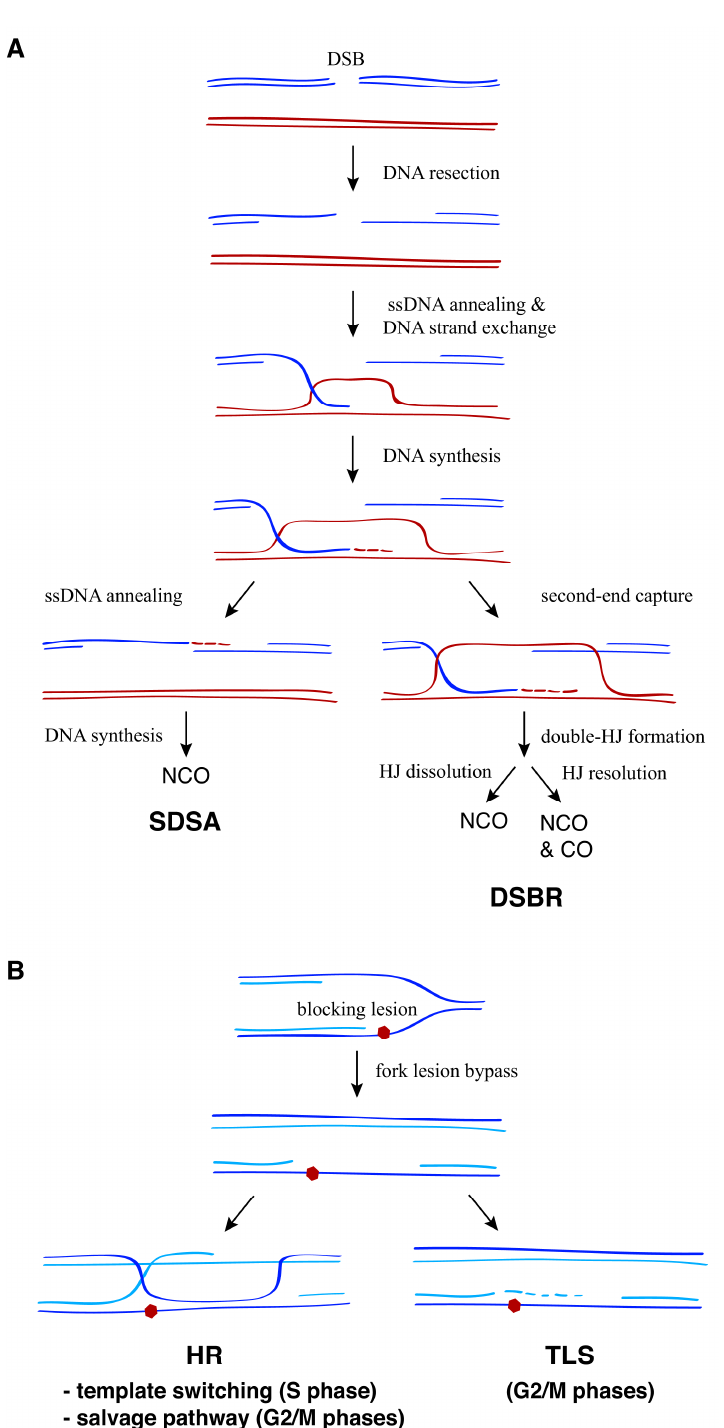
Figure 1. General strategies for the recombinational repair of double-strand breaks (DSBs) and replication associated single-stranded DNA (ssDNA) gaps. ( A ) In response to DSBs, the 5 (cid:48) -ends of the break are resected, leading to 3 (cid:48) -ended ssDNA molecules that search for and then invade a homologous DNA sequence through Rad51-dependent ssDNA annealing and DNA strand exchange reactions. This generates a D-loop intermediate that can be processed by two major pathways: synthesis-dependent strand annealing (SDSA) or double-strand break repair (DSBR). Whereas SDSA leads to non-crossovers (NCO), the output of DSBR (non-crossover versus crossover) depends on whether the double-Holliday junction (HJ) is dissolved by the STR complex or resolved by DNA structure-specific nucleases. ( B ) DNA damage tolerance (DDT) mechanisms promote replication